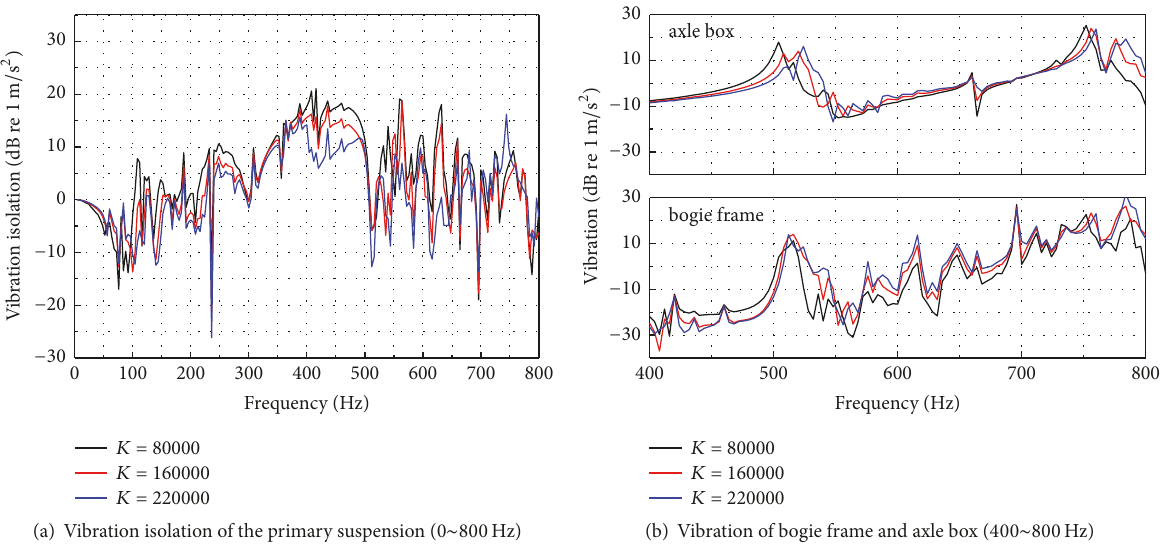
Figure 13: Different stiffness of the rotary arm rubber joint.